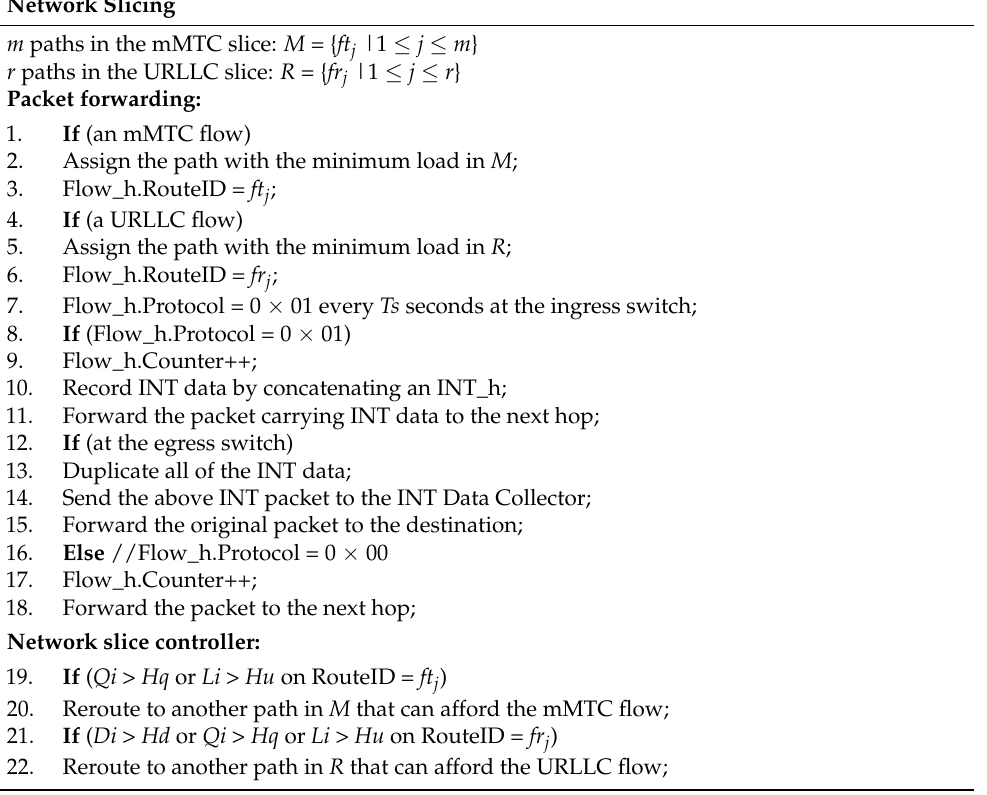
Table 3. Pseudocode of